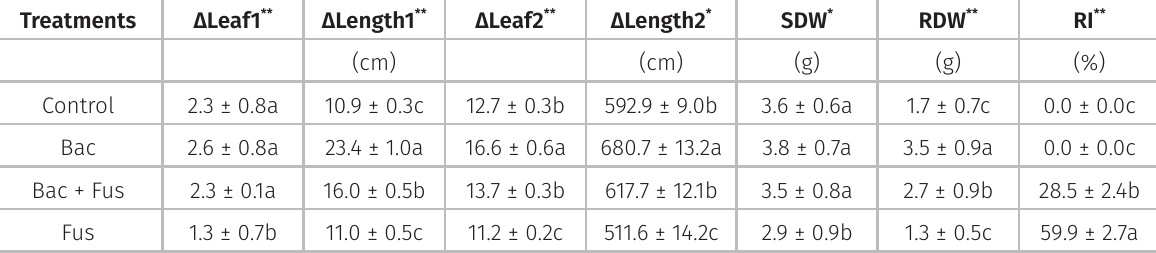
* Equal letters indicate no statistically significant difference according to ANOVA followed by Tukey test ( p ≤ 0.05). ** Equal letters indicate no statistically significant difference according to Kruskal-Wallis followed by Dunn-Bonferroni test ( p ≤